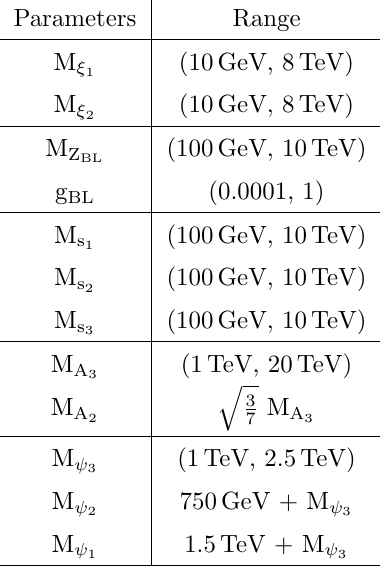
Table 3 . The parameters of our model and ranges used in the random scan